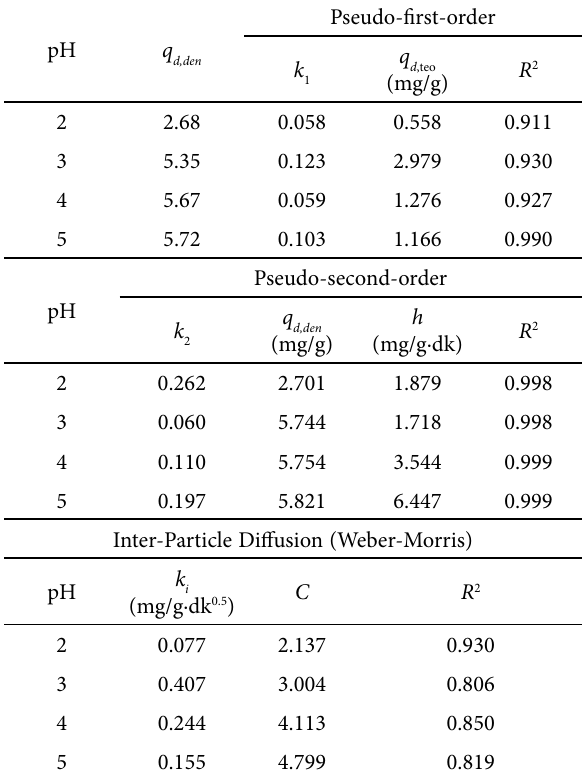
Table 2. Kinetic constant for biosorption of Cu 2+ ions onto tobacco